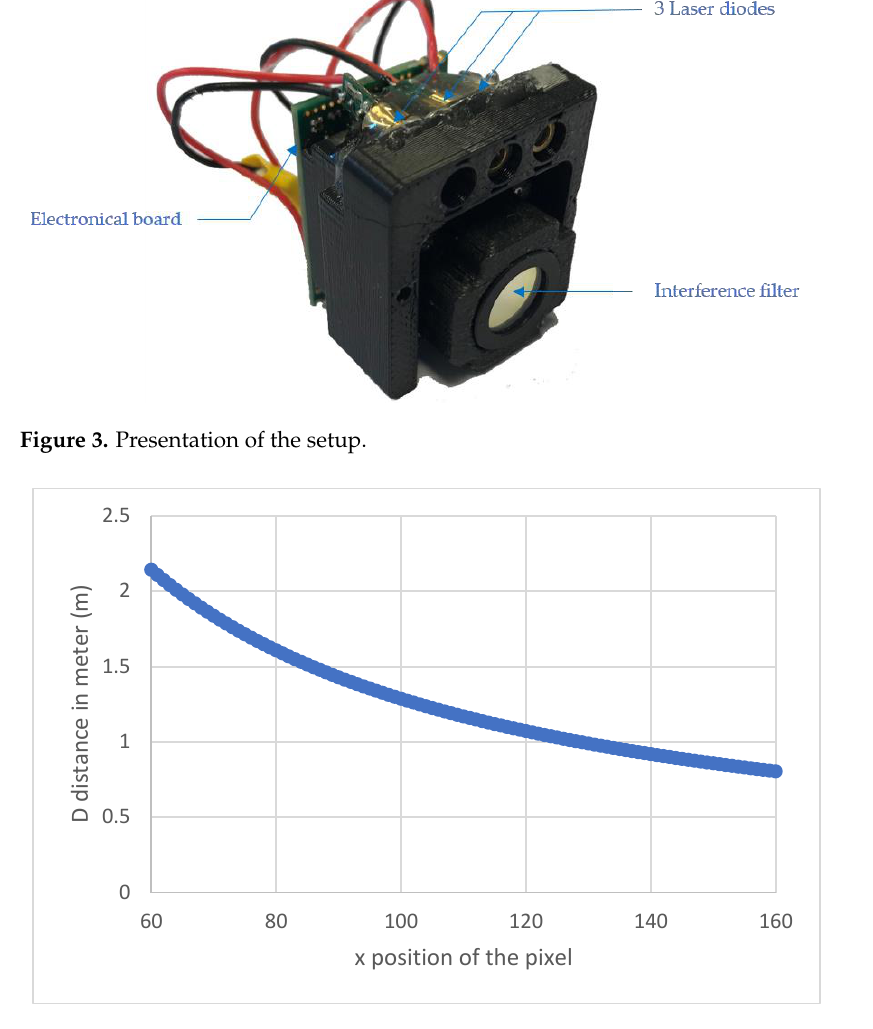
Figure 4. Variation of D with x for the central beam.